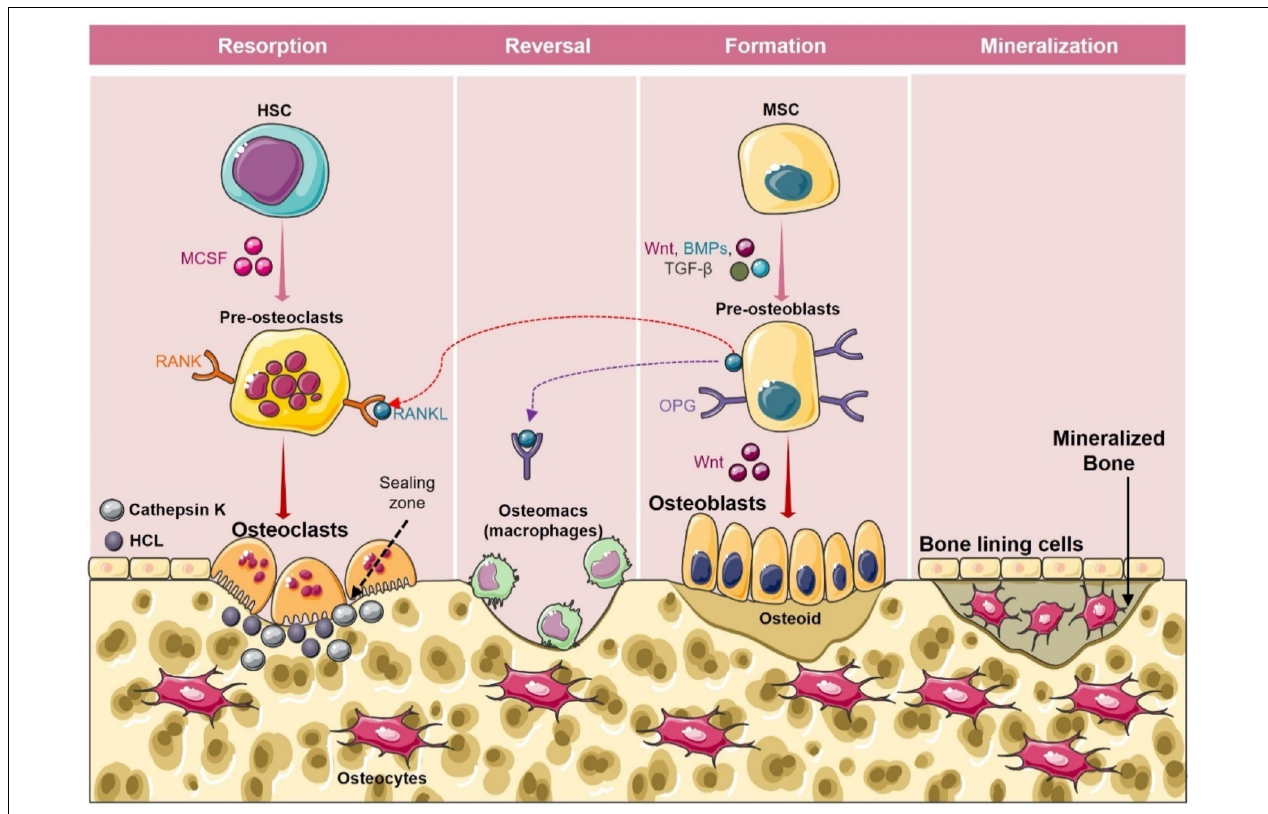
FIGURE 2 | Bone remodeling cycle. Bone remodeling occurs in four phases: (1) Activation phase: In this phase, M-CSF and RANKL promote the differentiation of osteoclast precursors into osteoclasts. (2) Resorption phase: During this phase mature osteoclasts with unique ruffled borders induce resorption of bone by secreting cathepsin K, and H + in the sealing zone. After resorption osteoclasts detach from the surface of the bone and undergo apoptosis. (3) Reversal phase: In the reversal phase osteoblasts’ precursors get differentiated into mature osteoblasts and are recruited to the resorption site. (4) Formation phase: In this phase osteoblasts get occupied in the resorbed lacuna and start depositing the bone matrix. After the formation phase, osteoid gets mineralized and bone surface returns to resting phase with bone lining